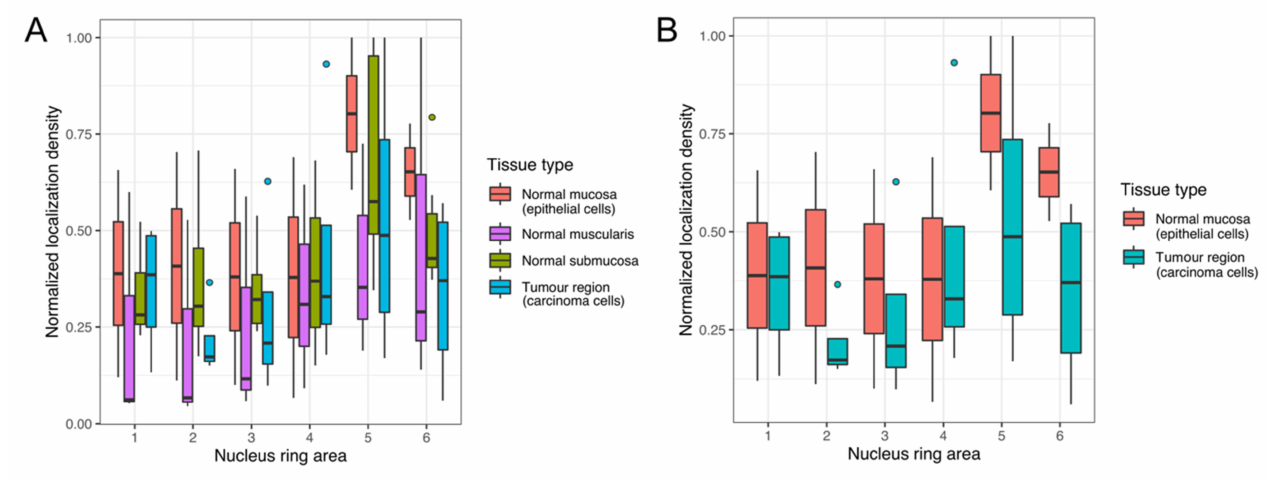
Figure 6. Box plot representations of the radial chromatin density analysis. Box plots show densities measured in rings of equal area from the nuclear centre (Nucleus ring area 1) to the nuclear periphery (Nucleus ring area 6) for cells taken from normal mucosa, normal muscularis, normal submucosa, carcinoma cells from the tumour region ( A ), and, for better comparison, from epithelial cells of normal mucosa and carcinoma cells of the tumour region ( B ). Horizontal lines in each box plot represent the median value of each one of the